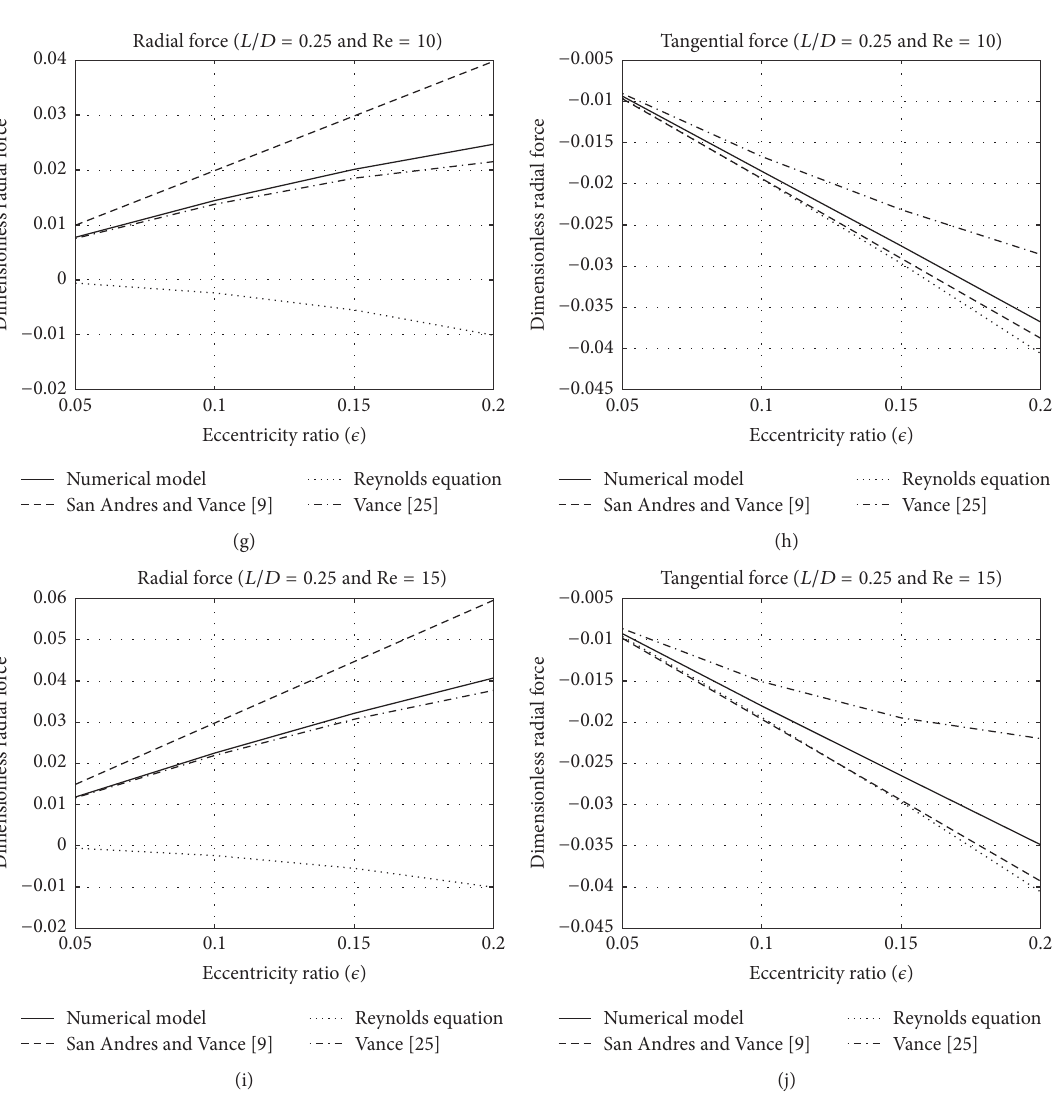
Figure 6: The effect of fluid inertia on the fluid film force components for small SFD journal eccentricity